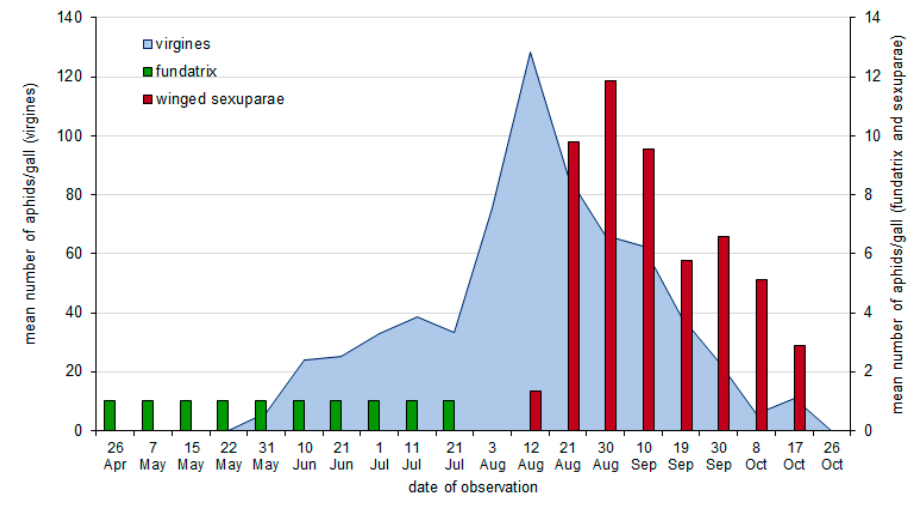
Figure 2. The mean number of aphids of Pemphigus spyrothecae in galls, in 2017.